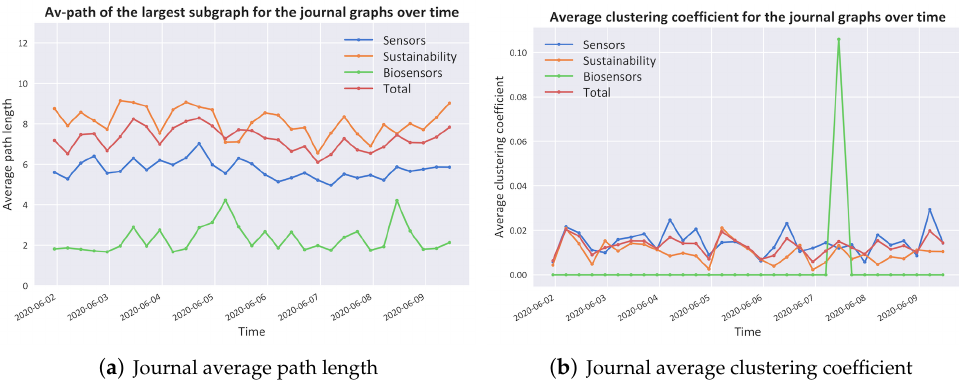
Figure 7. Properties of the journal graphs for every 6-hour time frame in a week of tweets.